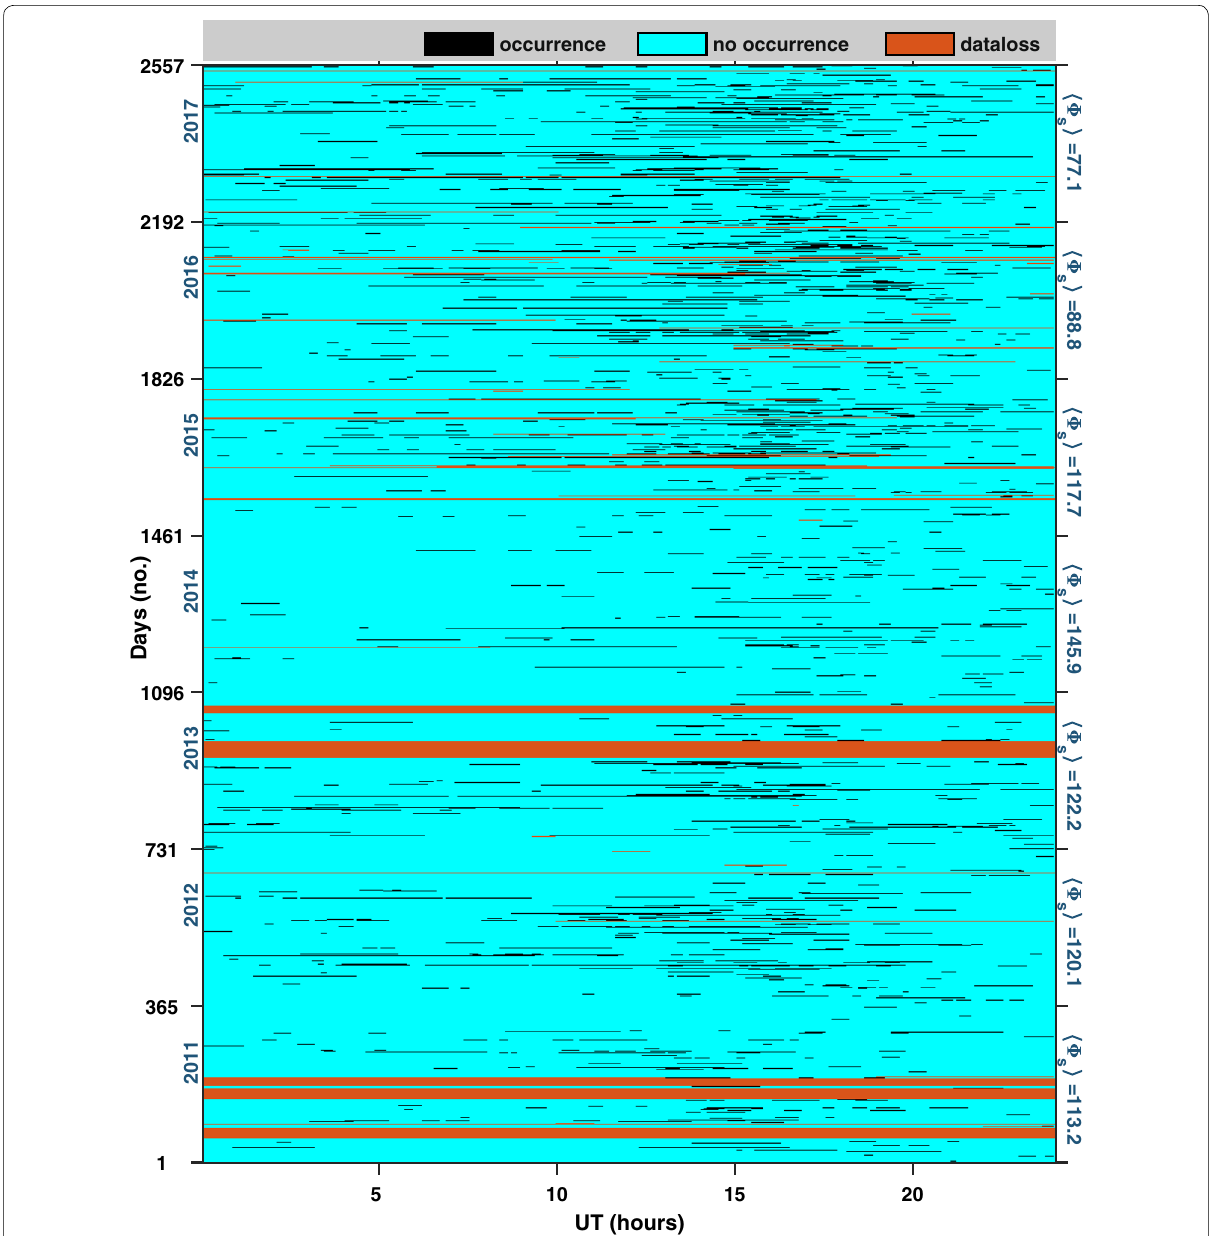
Fig. 3 Daily distribution of EMIC wave occurrence in time domain (0–24 UT h) for years 2011–2017. Each black, cyan, and brown color patch represents the occurrence, no occurrence of EMIC waves, and data loss, respectively. For each year the average value of solar flux (cid:31) (cid:31) s (cid:30) is given on the right-side. Here, UT LT-0.77 h. The resolution of plot is 5 min on x -axis and 1 day on y =